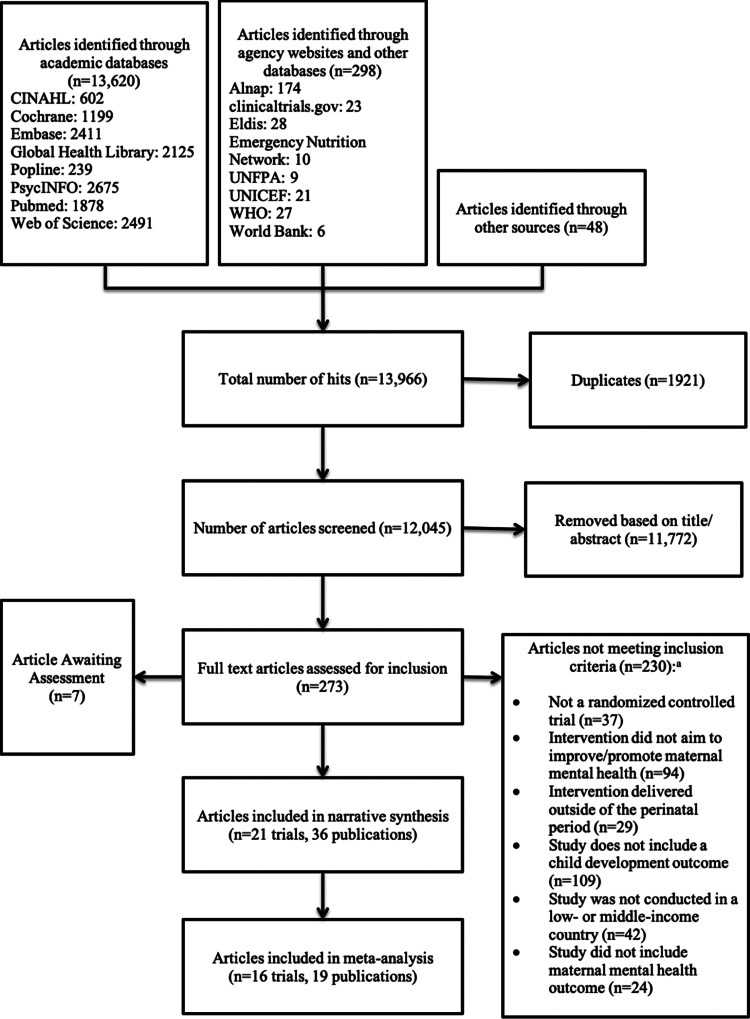
. PRISMA flow chart summarising selection of included studies.